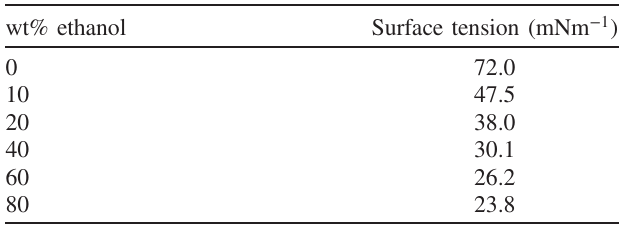
TABLE II. Surface tensions of used water-ethanol